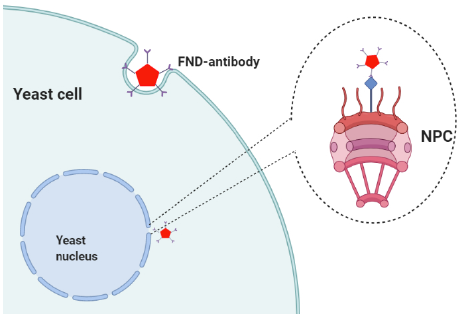
Figure 1. Schematic representation of the targeting strategy in a yeast cell. An antibody with a binding domain for the nuclear pore complex (NPC) was linked to fluorescent nanodiamonds (FNDs). After using a spheroplasting protocol, FNDs–antibodies (FND–AB) are ingested and will accumulate on the